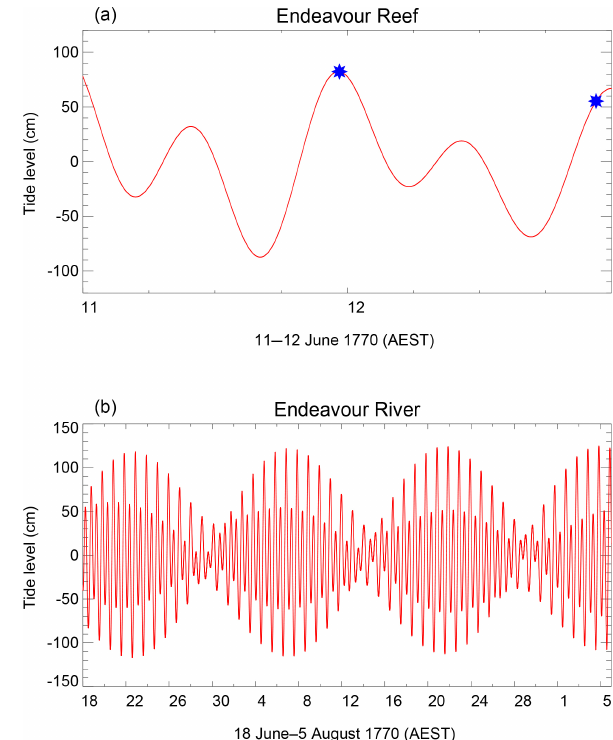
Figure 5. (a) The tide at Endeavour Reef on 11–12 June 1770 us- ing tidal constants from Cooktown. Mean time at this longitude (ap- proximately 145.5 ◦ E) is 18min behind Australian eastern standard time (AEST), which is 10h east of Greenwich. The blue stars indi- cate when the Endeavour struck the reef and was refloated. (b) The tide at Endeavour River (Cooktown) during 18 June–5 August 1770.